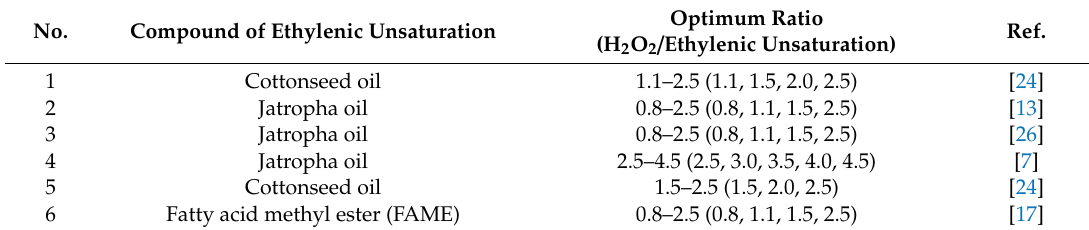
Table 2. Ratio of H 2 O 2 to ethylene unsaturated